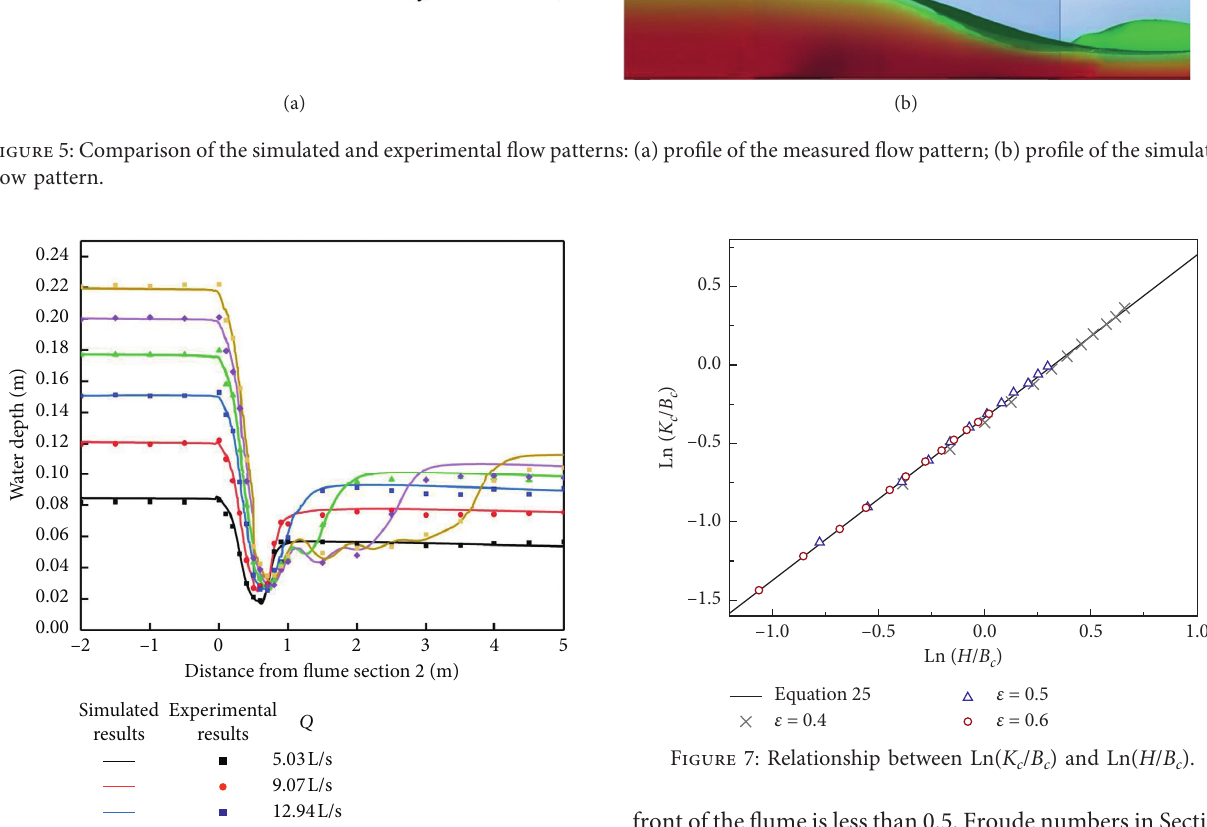
c / B c ) and Ln( H / B c